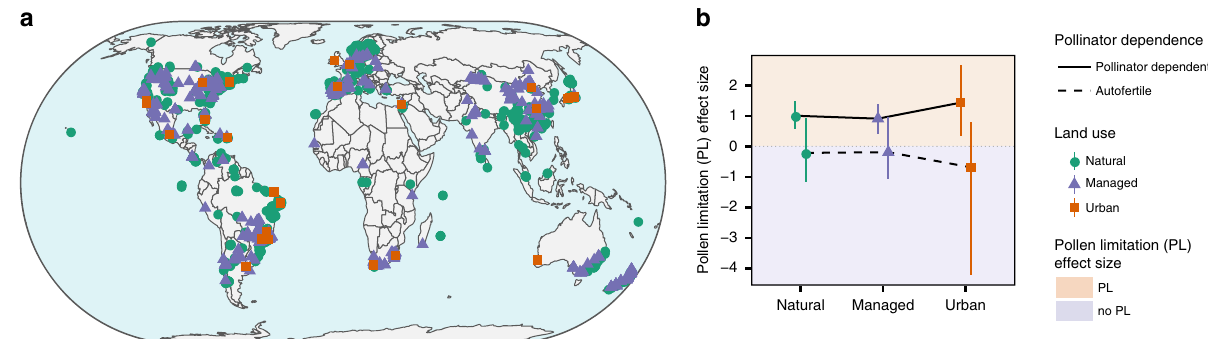
Fig. 1 The global distribution of data from the GloPL database (a) and an interaction plot showing the interaction between land use and pollinator dependence in respect to the effect size of pollen limitation (PL) (b). The point colour indicates the dominant land use category urban (orange), managed (purple), and natural (green) in ( a , b ). In the interaction plot, pollinator dependant plants are indicated by the solid line and autofertile plants by the dashed line. The area of the plot shaded orange indicates an effect size above (i.e. plants are PL) and the area of the plot shaded purple indicates an effect size below (i.e. plants are not PL). The interaction plot illustrates the average modelled result and 95% con fi dence intervals (shown as error bars) from 500 bootstrapped phylogenetic meta-analyses with the response variable PL and the interaction between land use and pollinator dependence as the predictor variables. Source data are provided as a Source Data